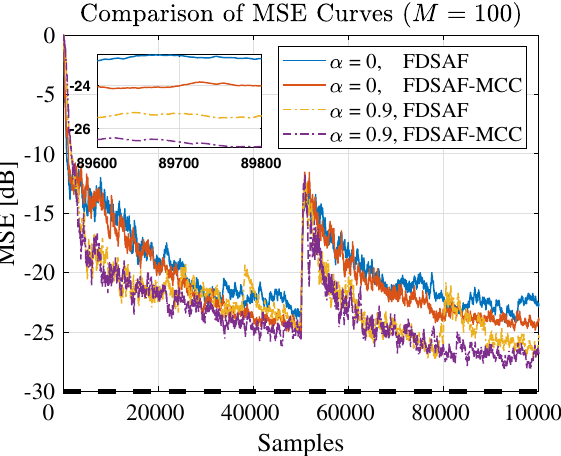
Figure 11. Experiment 3: MSE curves of FDSAF-MCC and FDSAF under impulsive noise and a sudden change.